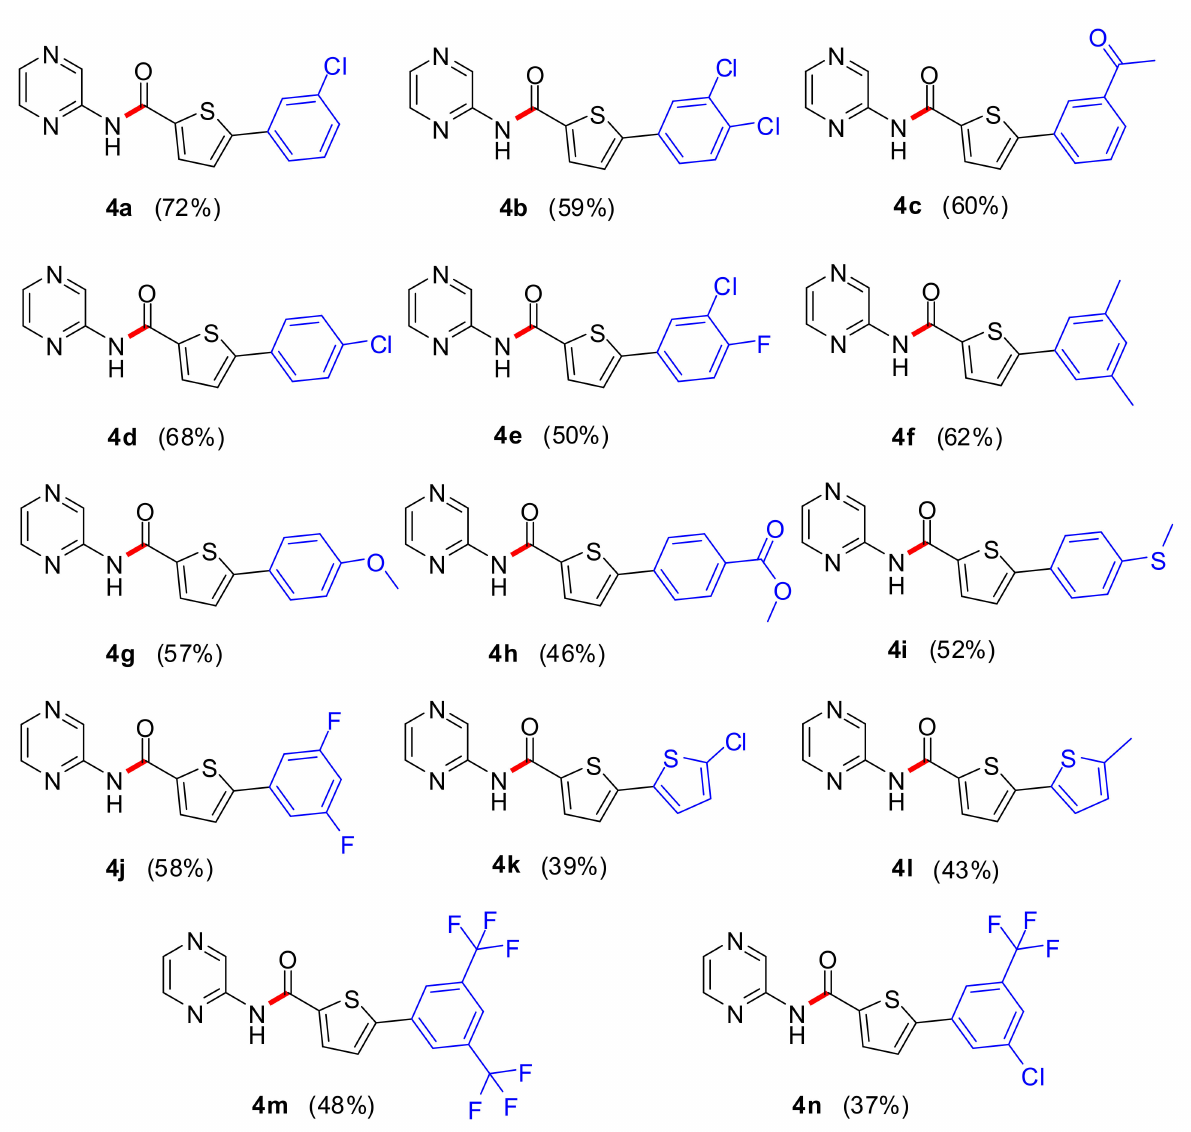
Figure 2. An overview of 5-bromo- N -(pyrazin-2-yl)thiophene-2-carboxamide derivatives via a Suzuki cross-coupling